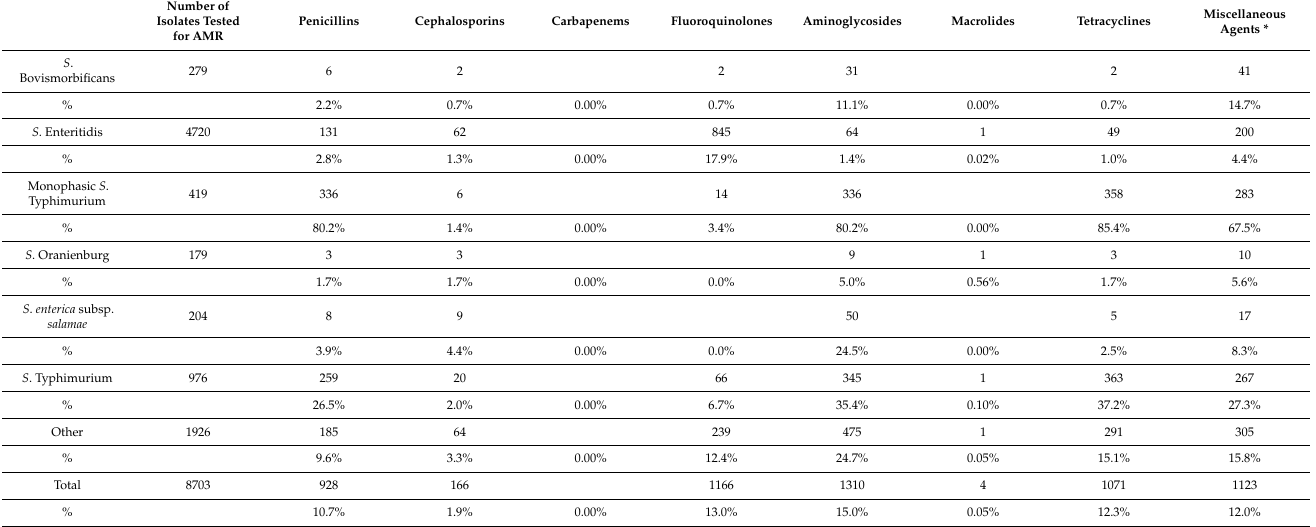
Table 4. The antimicrobial resistance of Salmonella spp. isolates of the selected serovars to the selected antimicrobials, Greece,